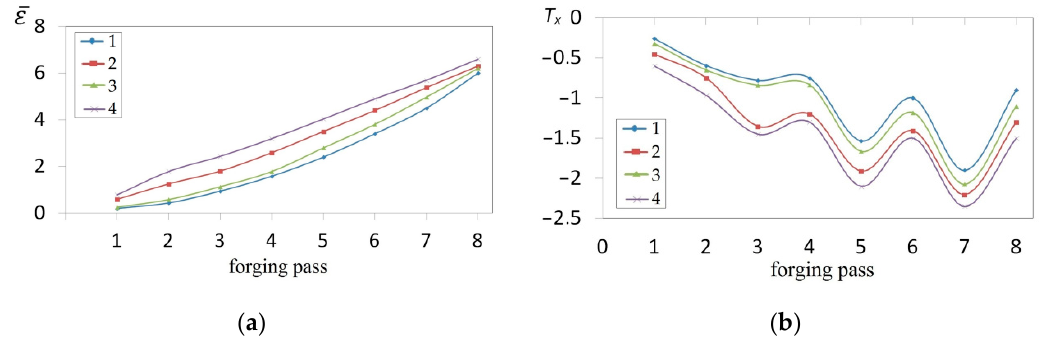
Figure 17. Influence of different passes upon the effective strain ε ( a ) and the stress triaxiality ratio Tx (b) in the axial zone in the course of the cogging in flat anvils of the forging with a concave cross-section for different angles and reduction ratio: 1— ε c = 0.22, α c = 135 ◦ ; 2— ε c = 0.51, α c = 135 ◦ ; 3— ε c = 0.22, α c = 165 ◦ ; 4— ε c = 0.51, α c = 165 ◦